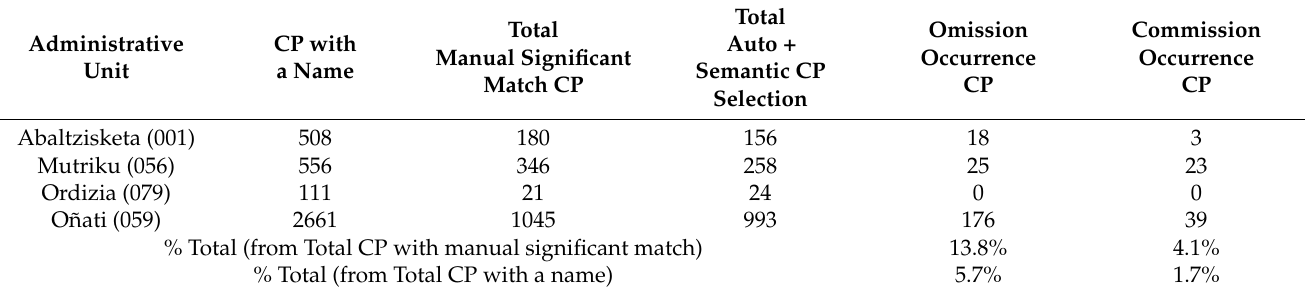
Table 5. Revision of errors of omission and commission in the sampled municipalities.